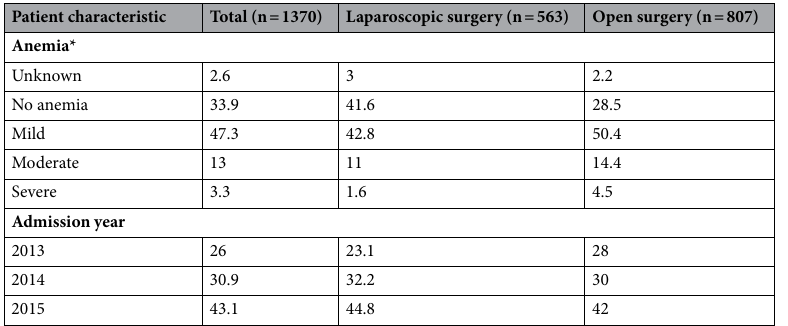
Table 1. Patient characteristics by laparoscopic versus open surgery, NSQIP 2013–2015. * p < 0.05; Other race includes American Indian, Alaskan Native, Native Hawaiian, Pacific Islander, or Asian; CI: confidence interval; SD: standard deviation.